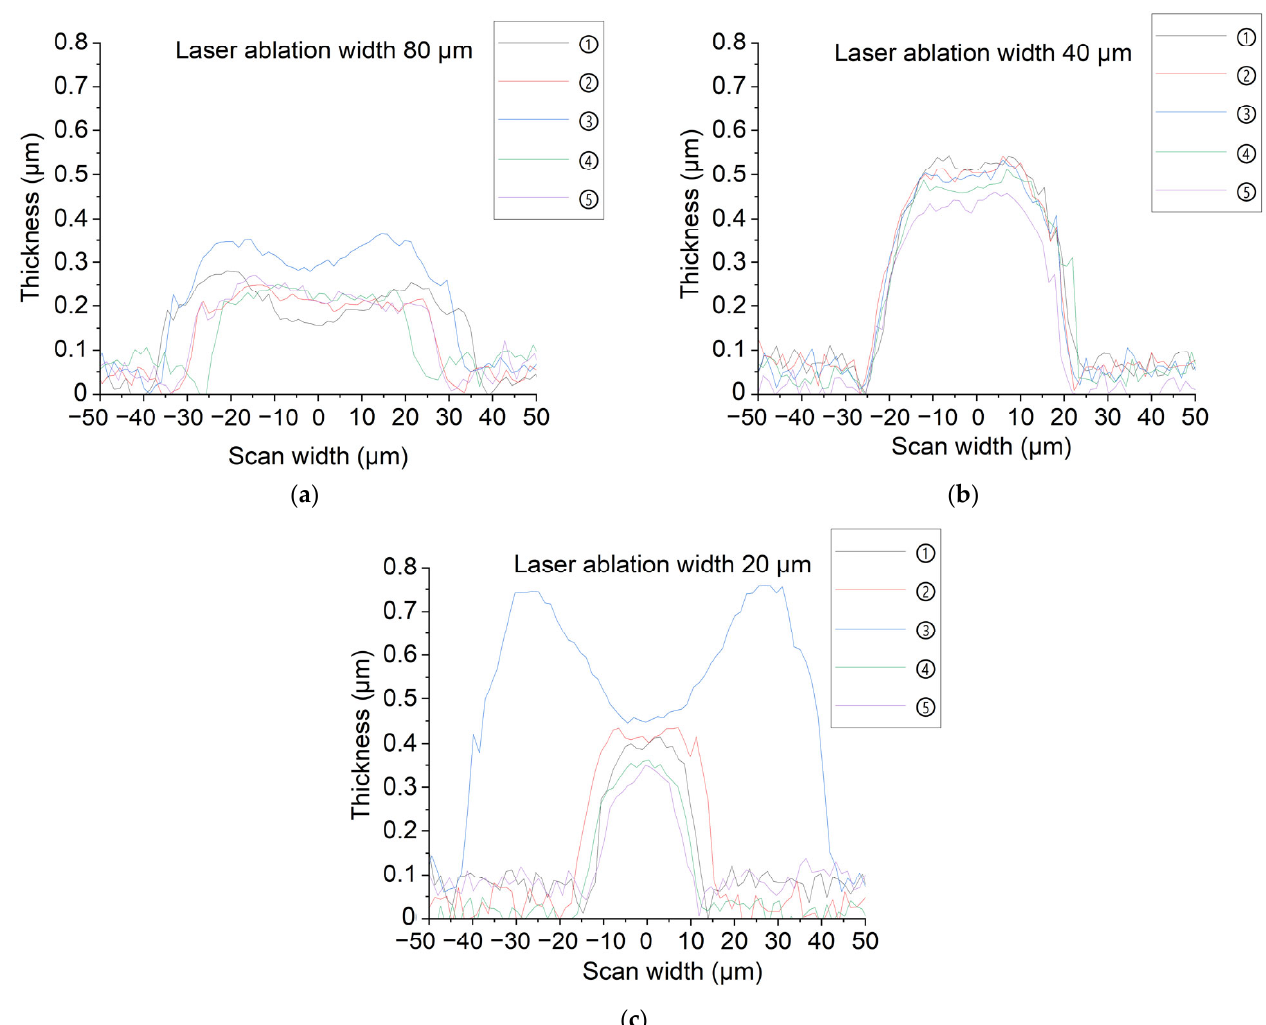
Figure 7. Cross-sectional thickness pro fi les at fi ve arbitrary locations (marked in Figure 5) along the printed lines with inkjet drop spacing of 10 µm and various laser ablation widths: ( a ) 80 µm, the printed lines with inkjet drop spacing of 10 µ m and various laser ablation widths: ( a ) 80 µ m, ( b ) 40 µm, and ( c ) 20 µm. ( b ) 40 µ m, and ( c ) 20 µ